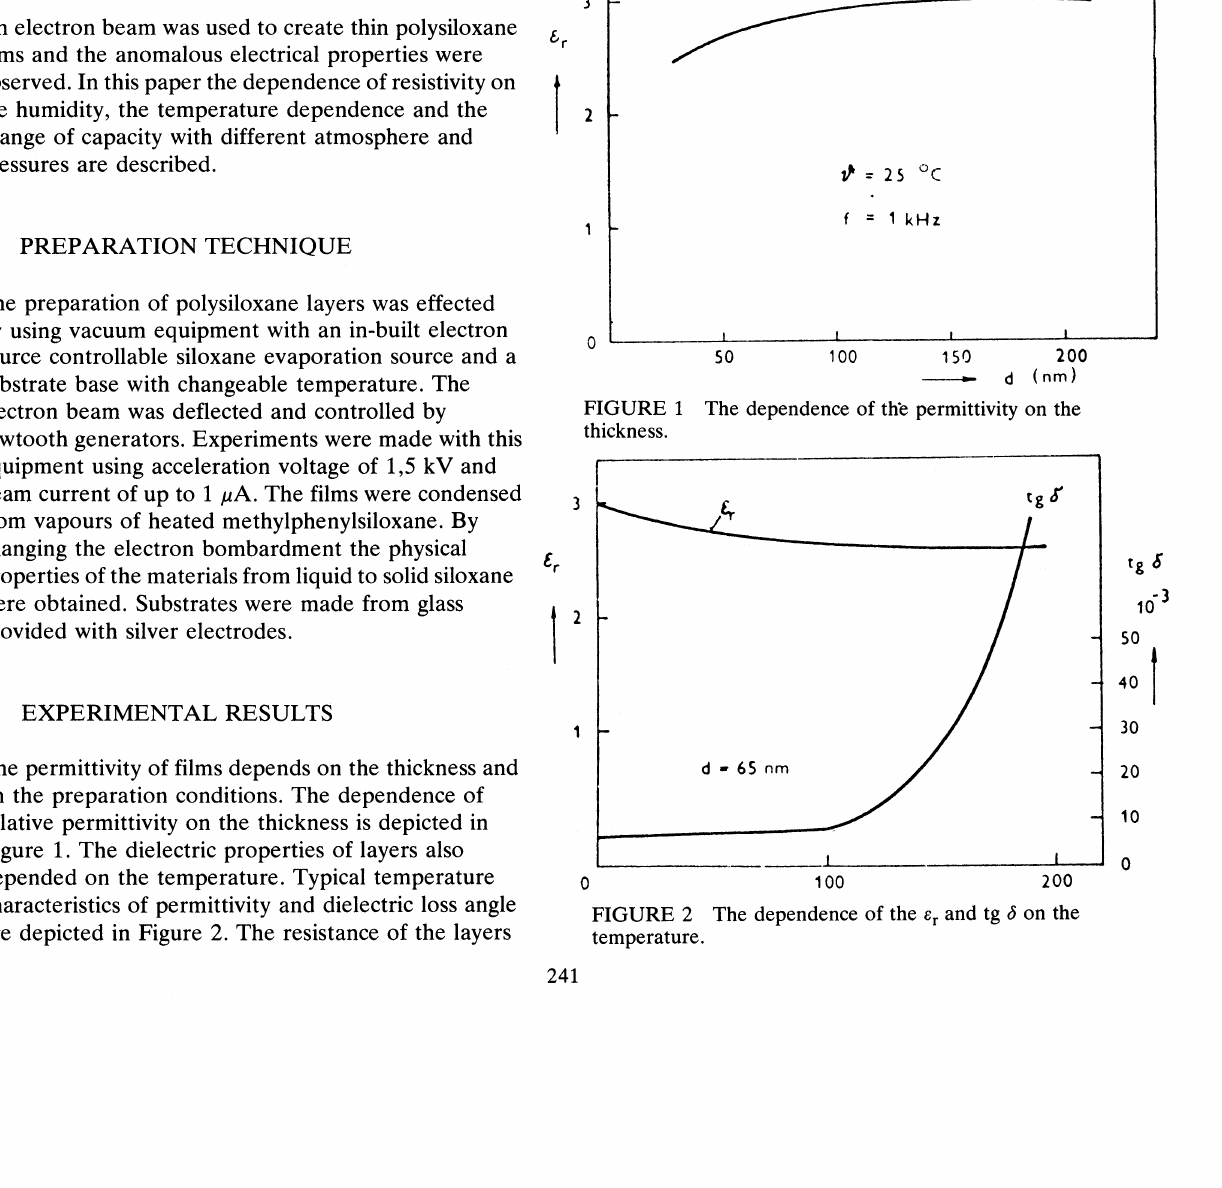
FIGURE The dependence of th permittivity on the thickness.